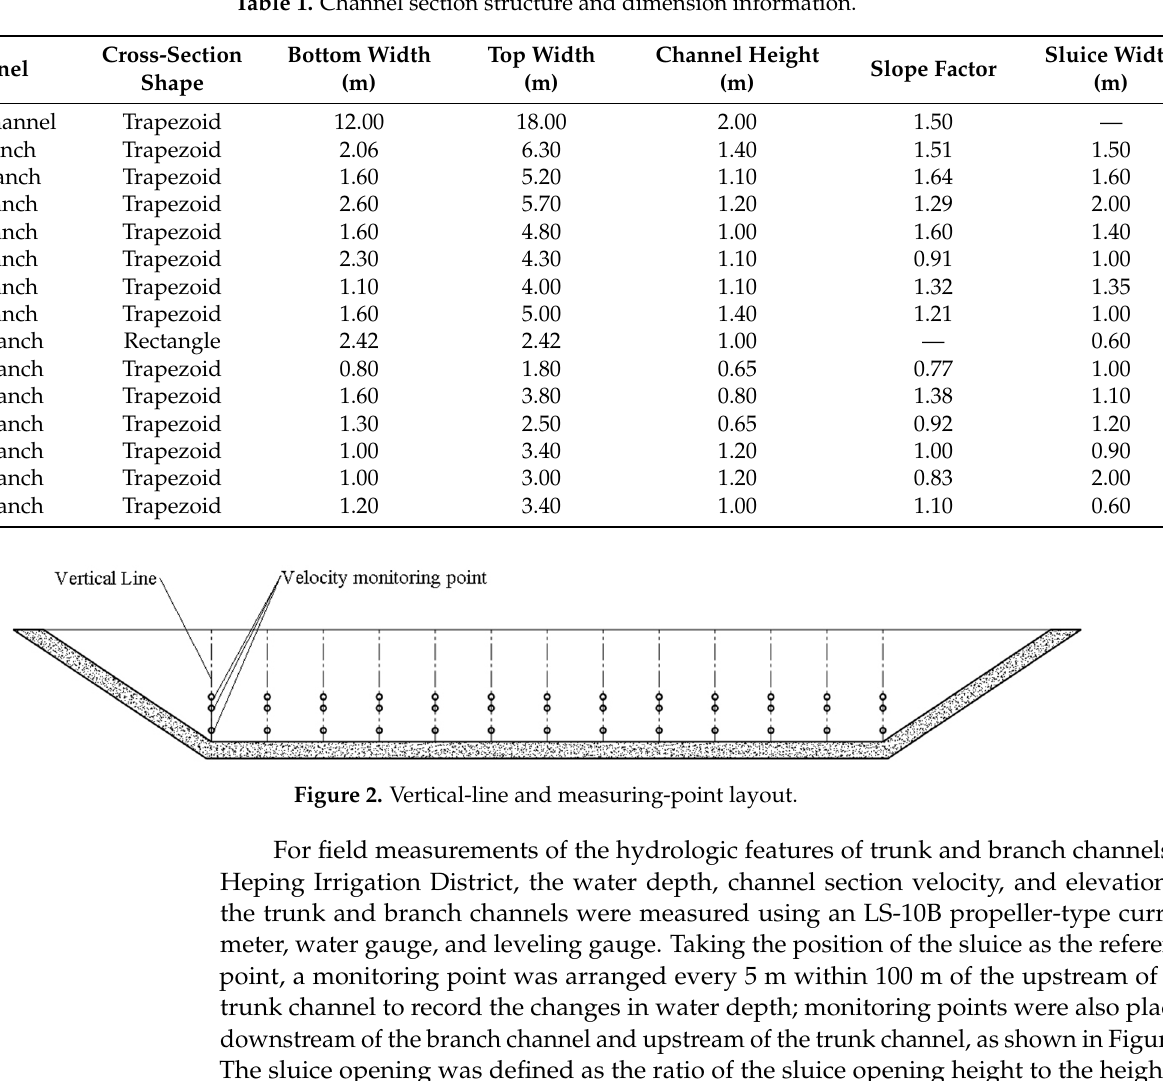
Table 1. Channel section structure and dimension information.